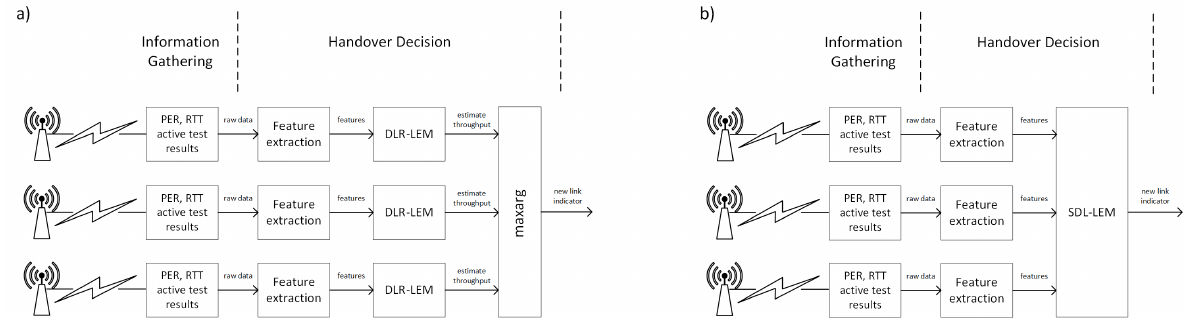
Figure 6. Link selection procedure according to: ( a ) DLR-ESM method, ( b ) SDL-LEM